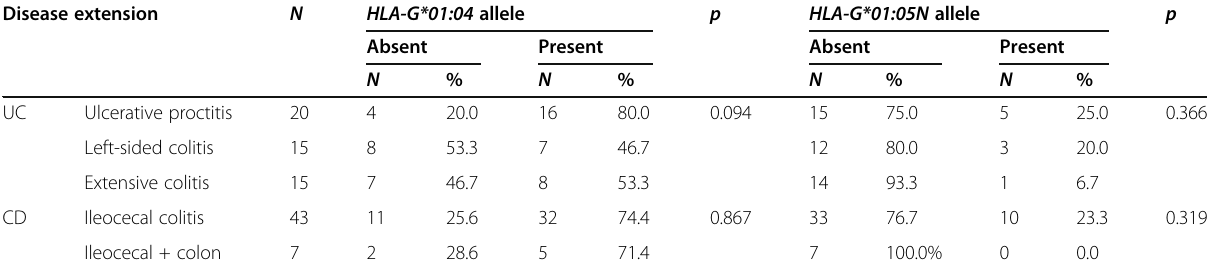
Table 6 HLA-G*01:04 and HLA-G*01:05N frequencies in inflammatory bowel disease patients (ulcerative colitis and Crohn ’ s disease) classified according to disease extension Disease